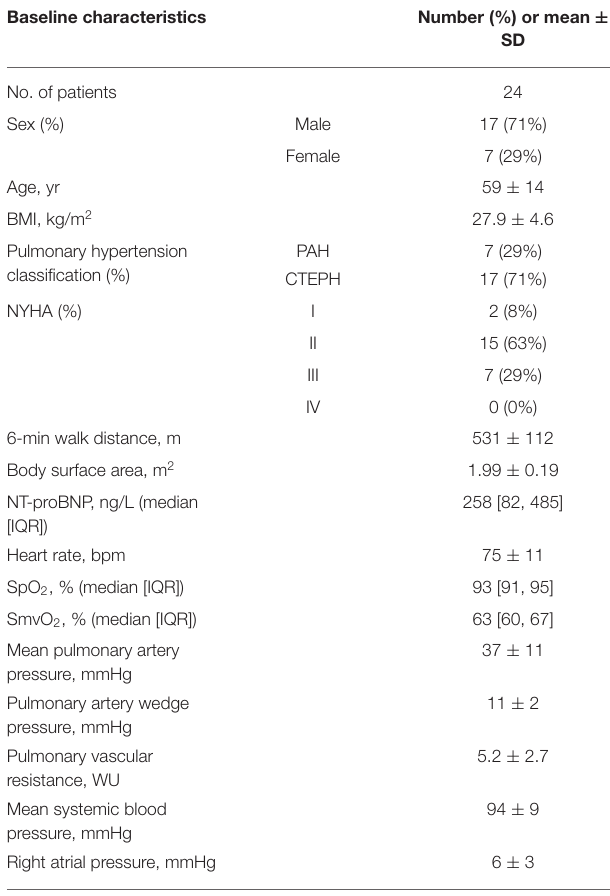
TABLE 1 | Baseline characteristics of the study population.